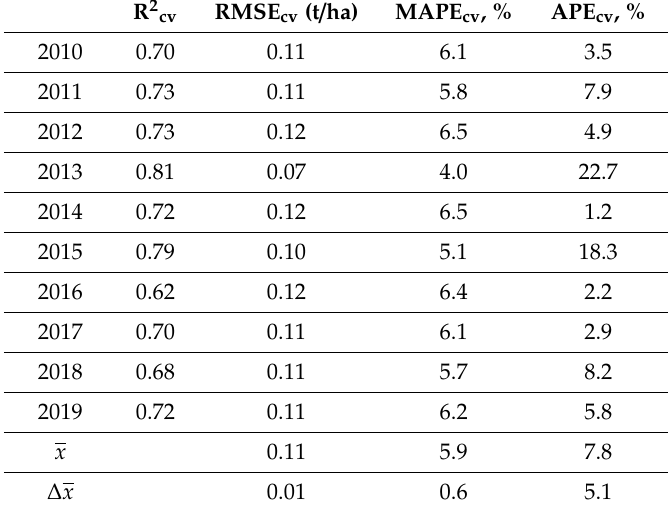
Table 8. Cross-validated coe ffi cient of determination (R 2 cv ), root-mean-square error (RMSE cv ), mean absolute percentage error (MAPE cv ), and absolute percentage error (APE cv ), calculated in a one-leave-out cross − validated approach for the regression model.